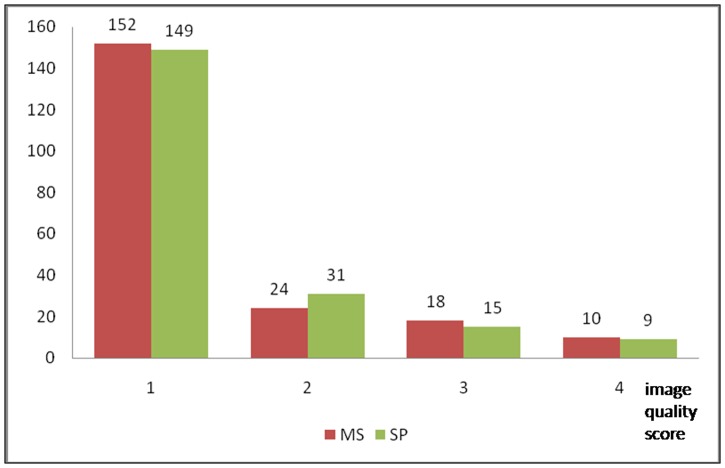
Comparison of subjective image quality of MS and SP phases.MS = Manual Selection, SP = Smart Phase. Image quality score: 1 = excellent, 2 = good, 3 = intermediate, 4 = poor.